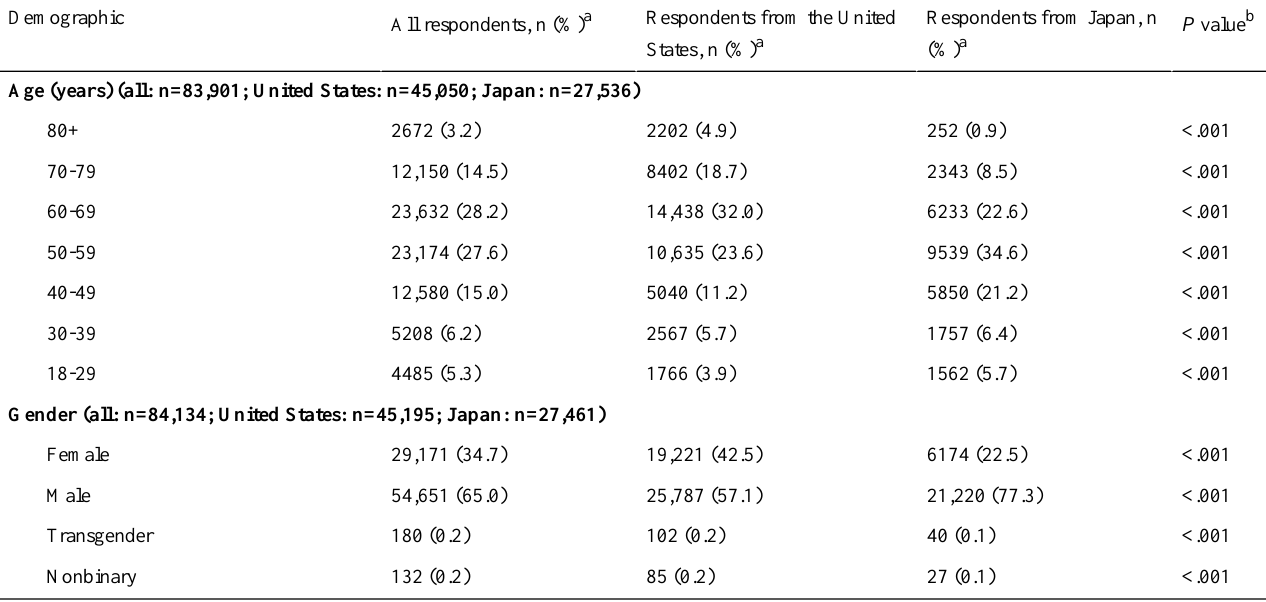
Table 2. Demographics of all respondents (who completed the consent portion) of a web-based questionnaire about COVID-19 symptoms recruited through the Microsoft News platform.